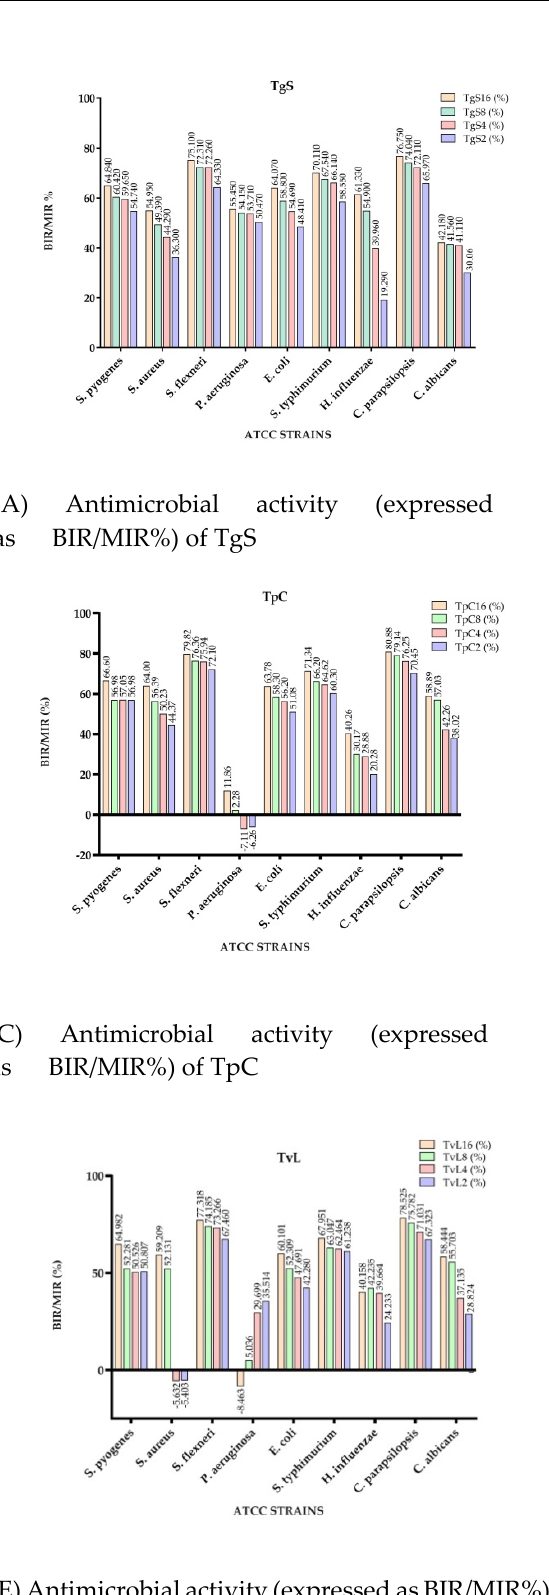
Figure 2. Antimicrobial activity of analyzed EOs expressed as BGR/MGR (%): ( A ) TgS; ( B ) TpB; ( C ) TpC; ( D ) TpP; ( E ) TvL.